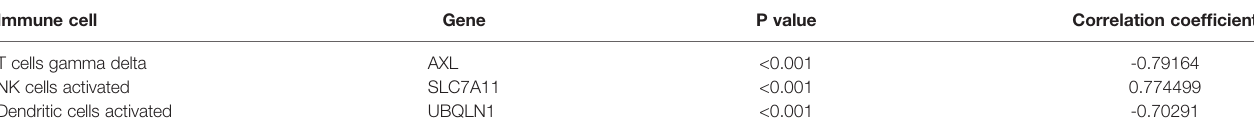
TABLE 1 | Correlations between critical OSGs and immune